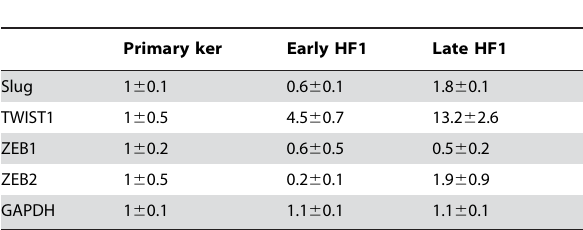
Table 3. Expression of transcriptional regulators of EMT